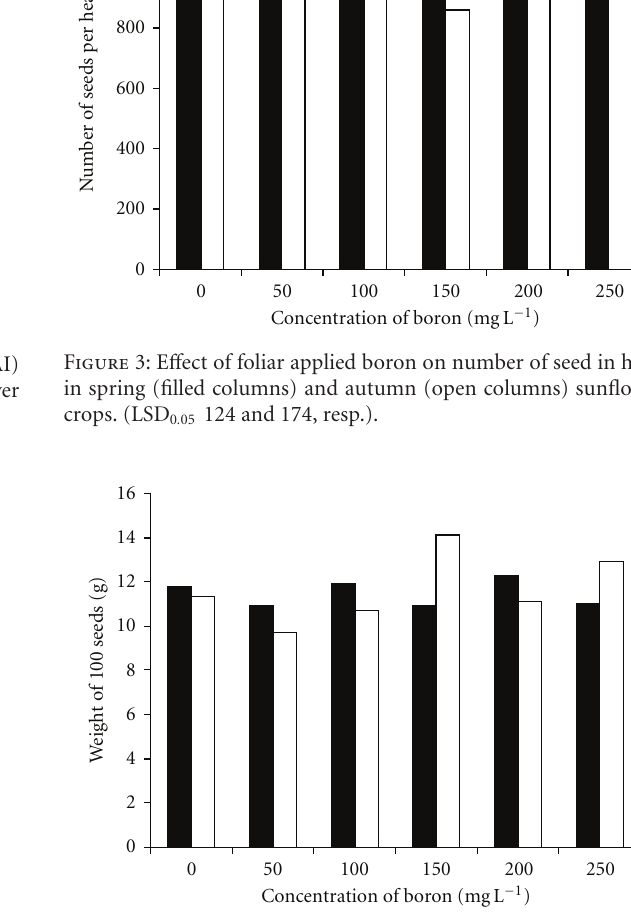
Figure 2: E ff ect of foliar applied boron on total dry matter (t ha − 1 ) in spring (filled columns) and autumn (open columns) sunflower crops. (LSD 0 . 05 1.890 and 3.889, resp.).